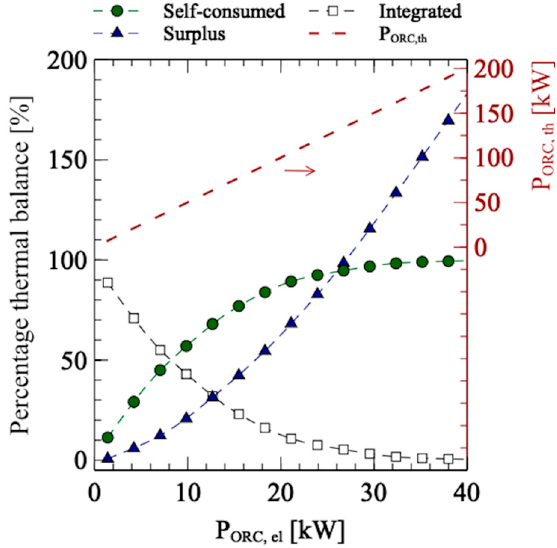
Figure 8. Influence of ORC size on thermal power and yearly energy balance (self-consumed, surplus and integrated energy).